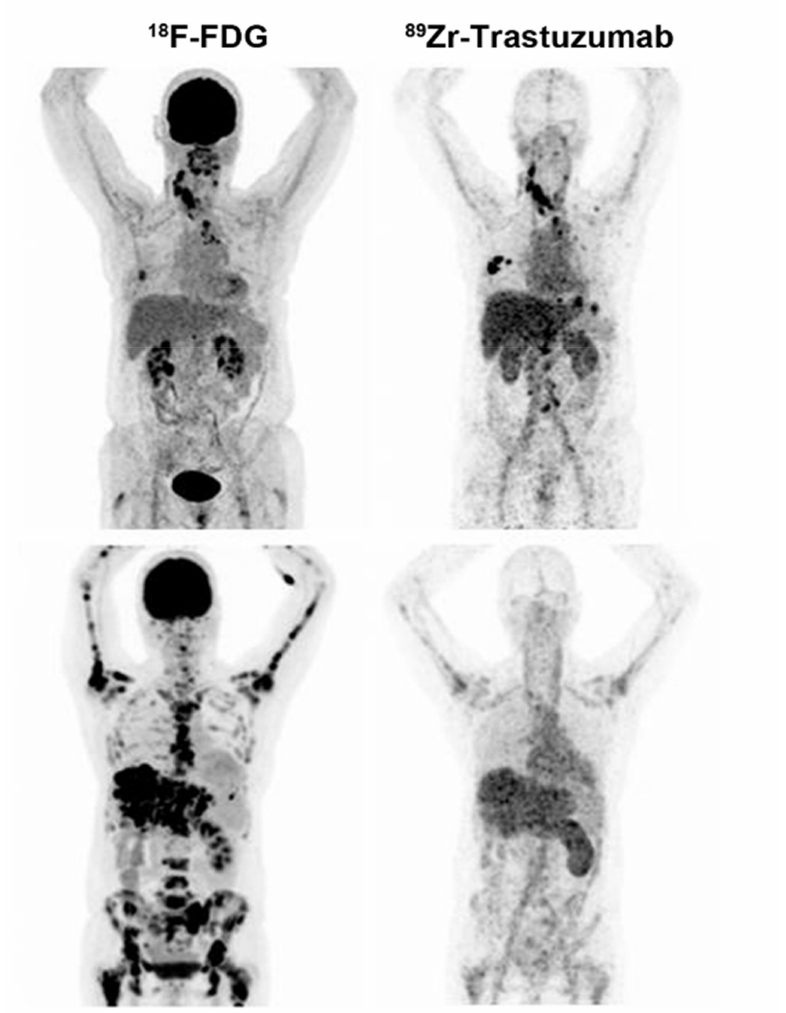
Figure 7. 18 F-FDG and 89 Zr-trastuzumab PET scans of a patient with a 89 Zr-trastuzumab PET scan considered HER2-positive breast cancer ( up ) and a 89 Zr-trastuzumab PET scan considered HER2 negative ( bottom )